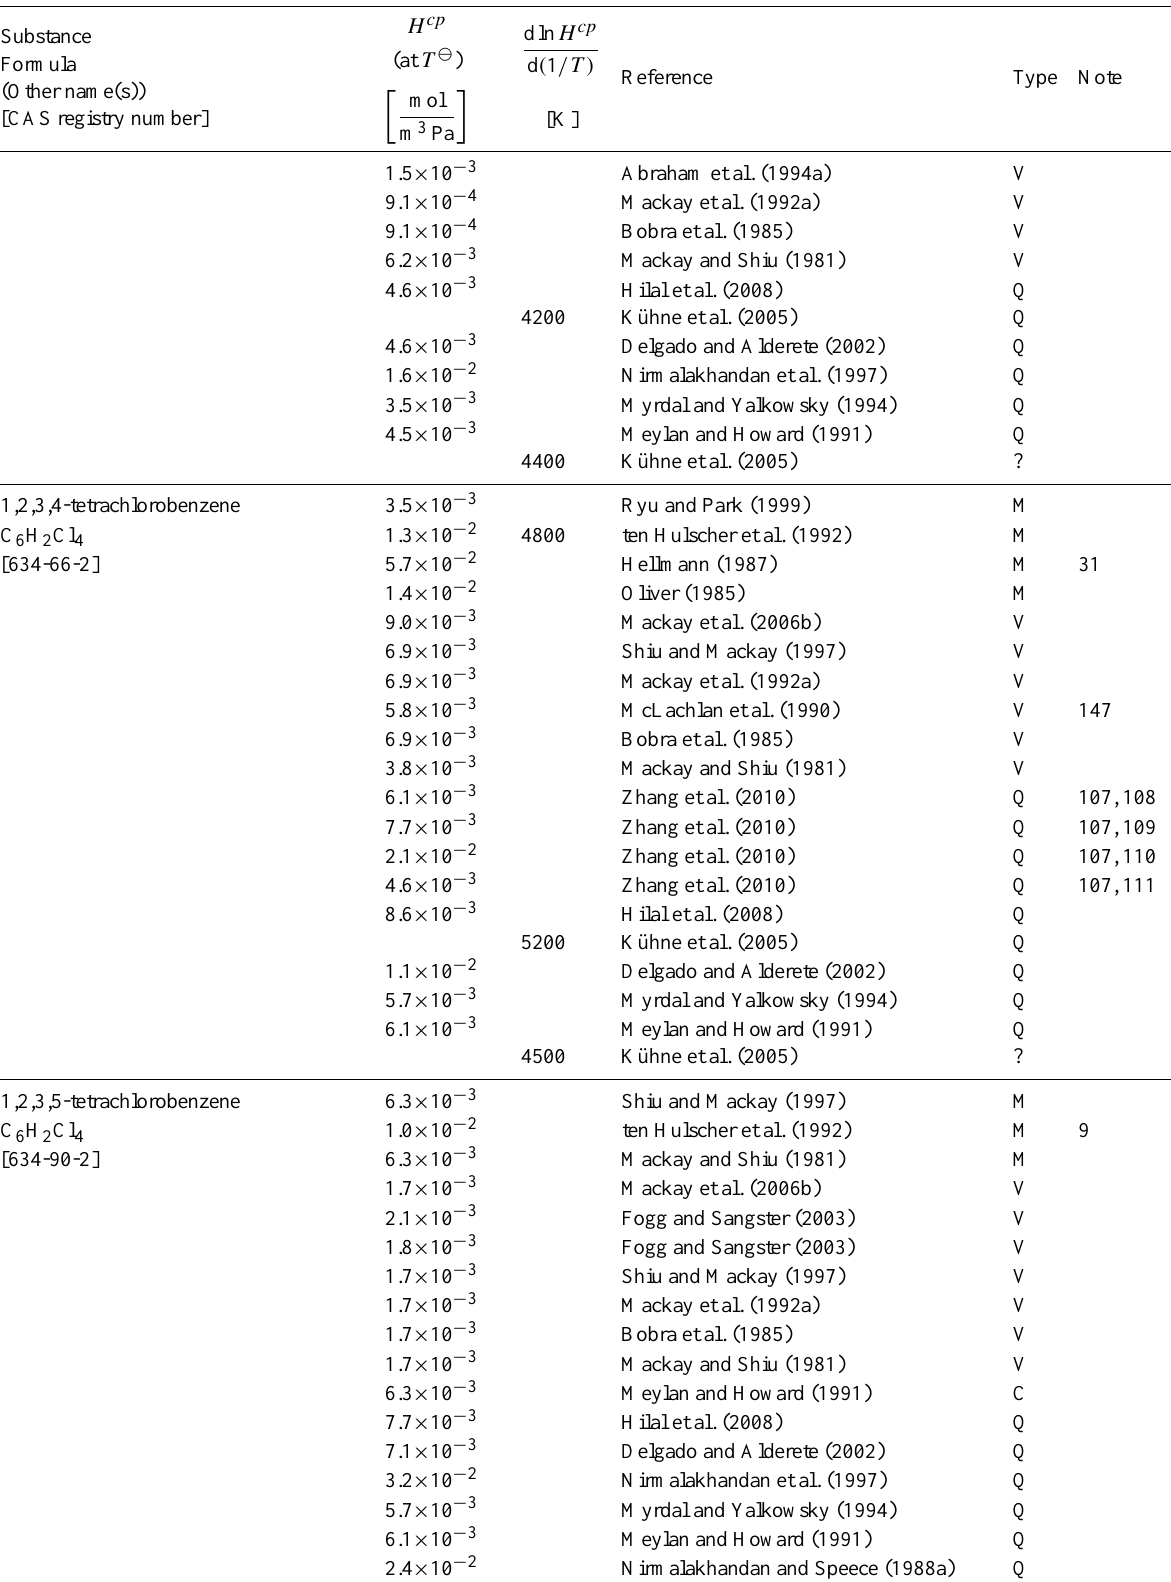
Table 6: Henry’s law constants for water as solvent